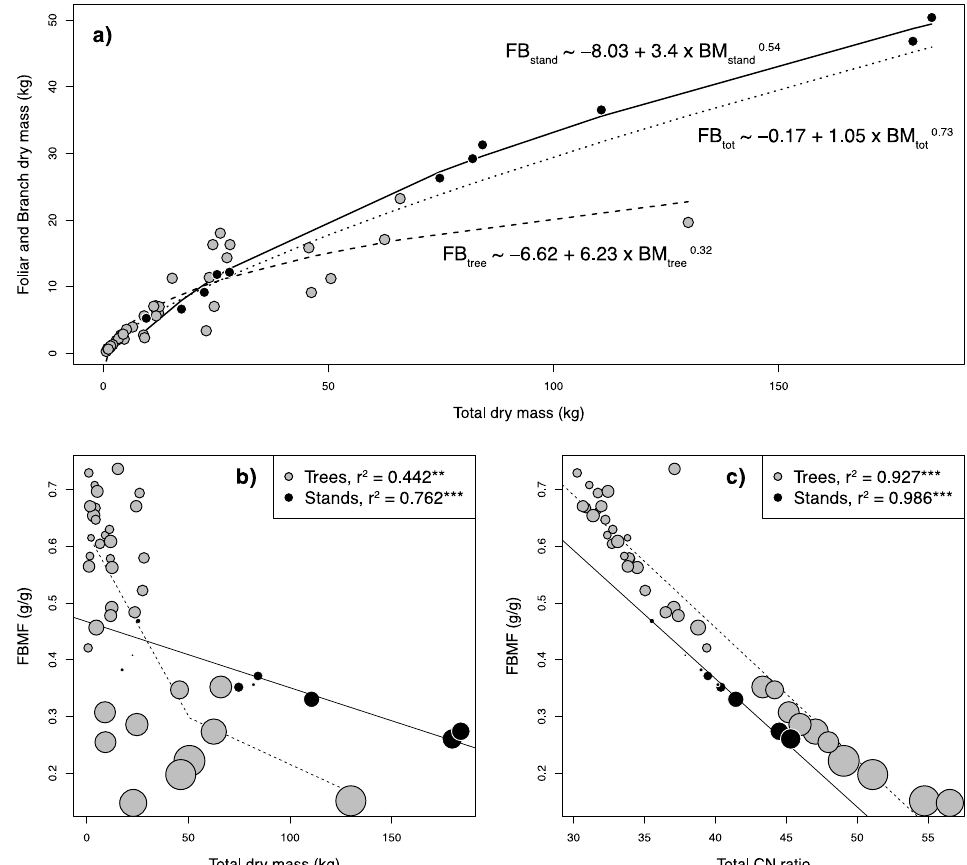
Figure 1. ( a ) Relationship between foliar and branch mass (FB) and total dry biomass (BM). Lines fitted follow the allometric relationship FB ~ a + b × BM c . ( b ) Regression between total biomass and the foliar and branch mass fraction of total biomass (FBMF). The correlation for stands is linear, while the correlation for trees is best described as a segmented regression after testing for a change in slope using Davies’ test ( p < 0.05). The breakpoint was estimated at a FBMF of 0.3. Point size indicates plant height. ( c ) Regression between total C/N ratio and the foliar and branch mass fraction of total biomass (FBMF). Point size indicates plant height. ** = p < 0.01, *** = p < 0.001.